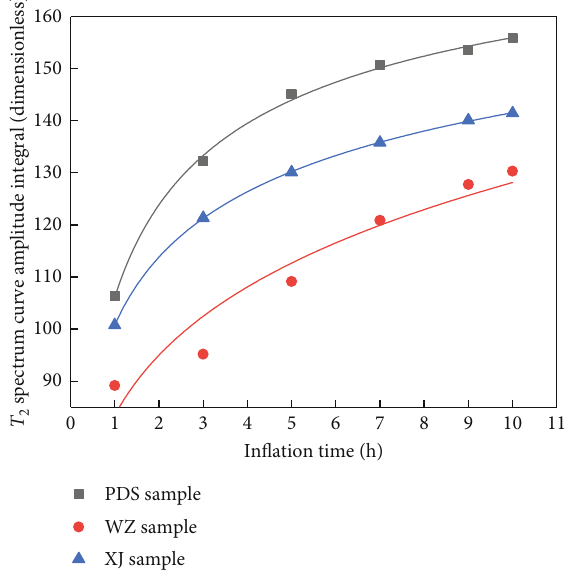
Figure 6: Relationship between in fl ation time and integrated amplitude of free